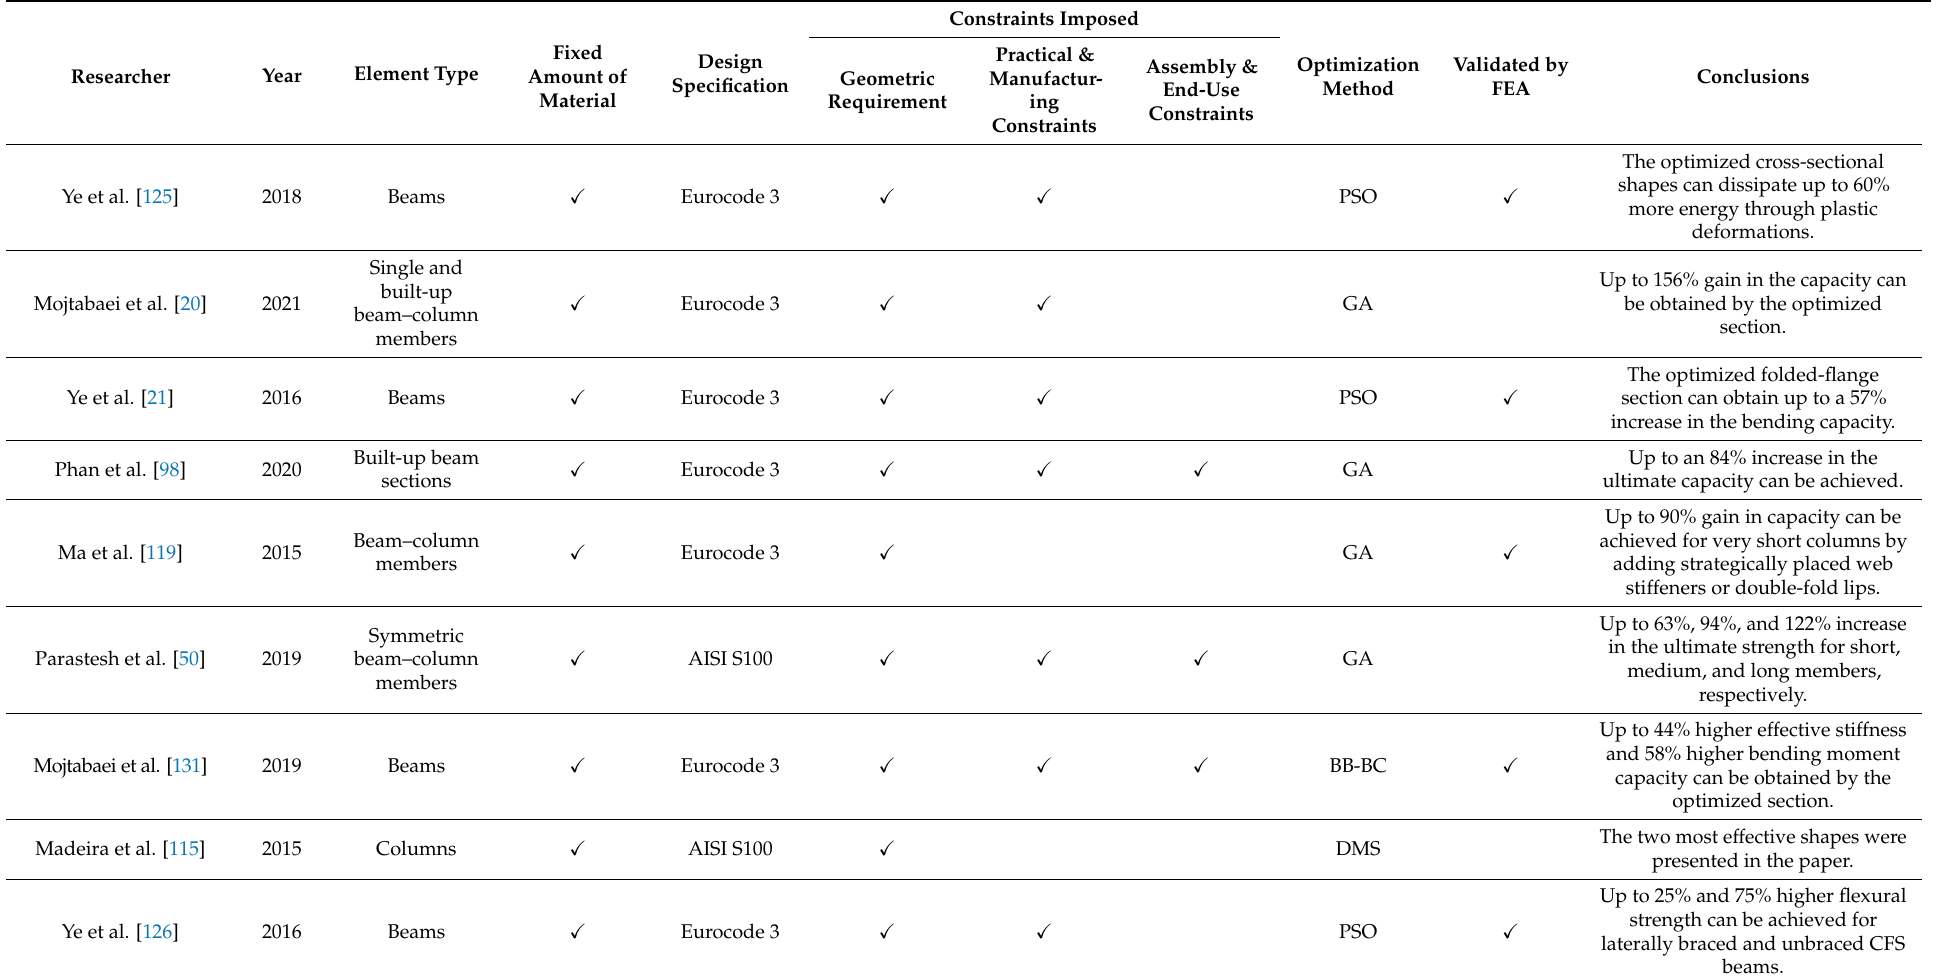
Table 1. Summary of the relevant research studies available in the literature for structural optimization of CFS